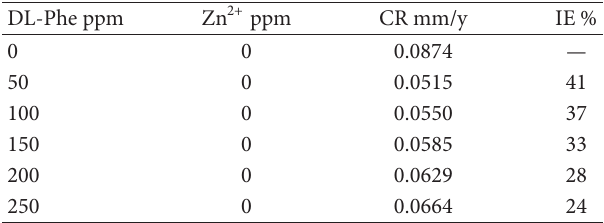
T 2: Corrosion rates (CRs) of carbon steel immersed in well water in the presence and absence of inhibitor system at various concentrations and the inhibition efficiencies (IEs) obtained by weight loss method.